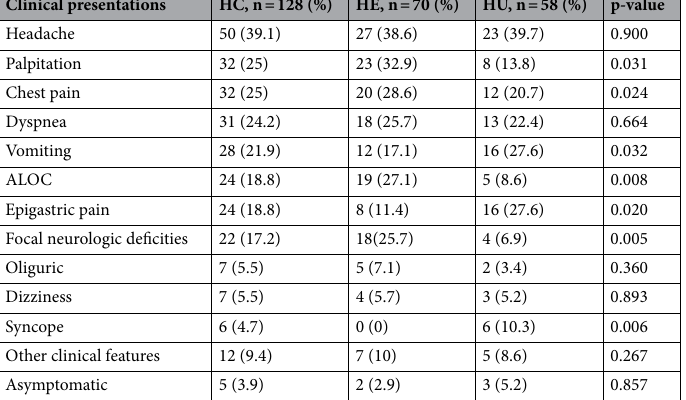
Table 3. Initial clinical presentation of hypertensive crises patients. HC hypertensive crisis, HE hypertensive emergency, HU hypertensive urgency.